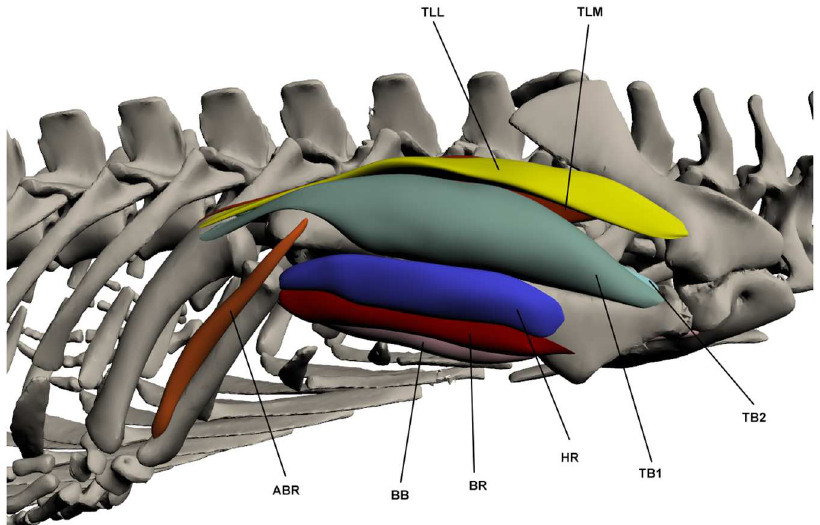
Fig 9. Intrinsic muscles of the forelimb: elbow extensorsand flexors. TLL: Triceps longuslateralis ,TLM: Triceps longus medialis ,ABR: Abductor radialis ,BB: Biceps brachii ,BR: Brachialis , HR: Humeroradialis , TB1-2: Triceps brevis 1–2